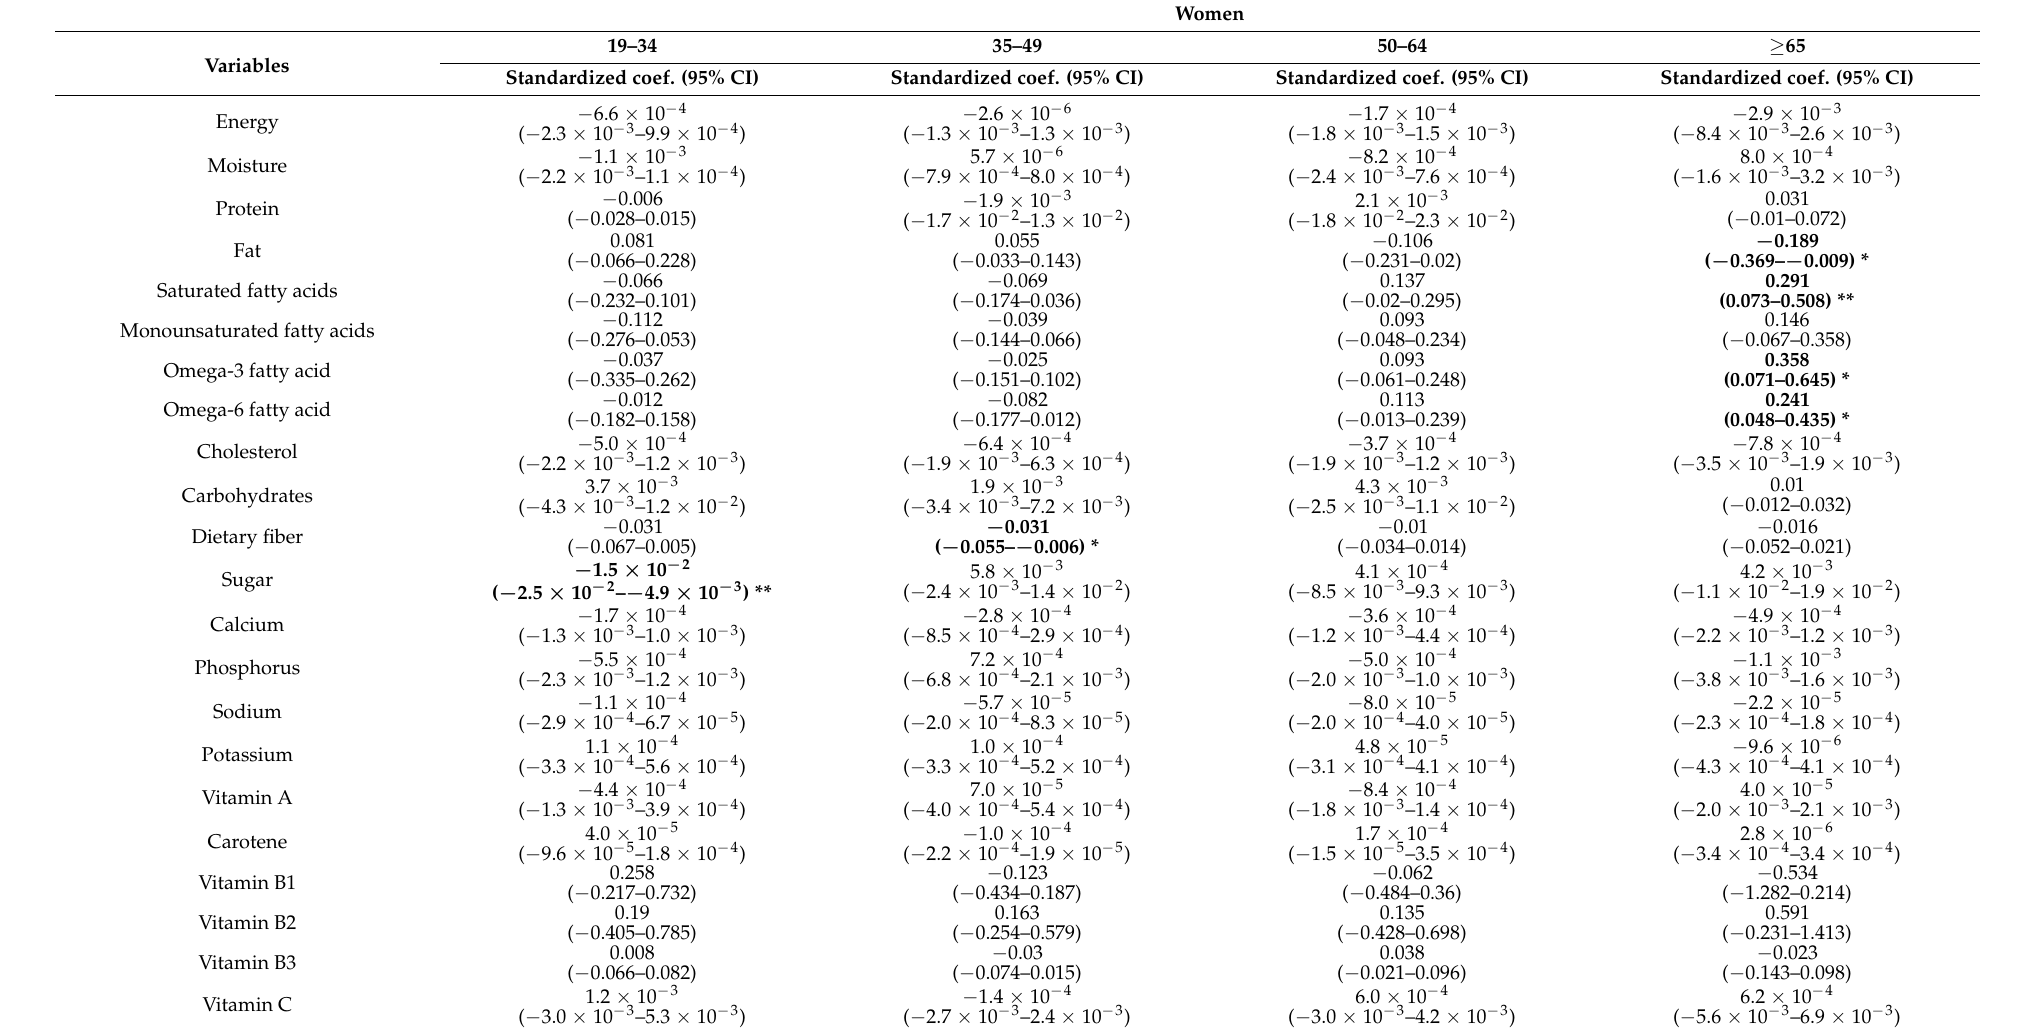
Table 4. Multiple linear regression results for the women’s